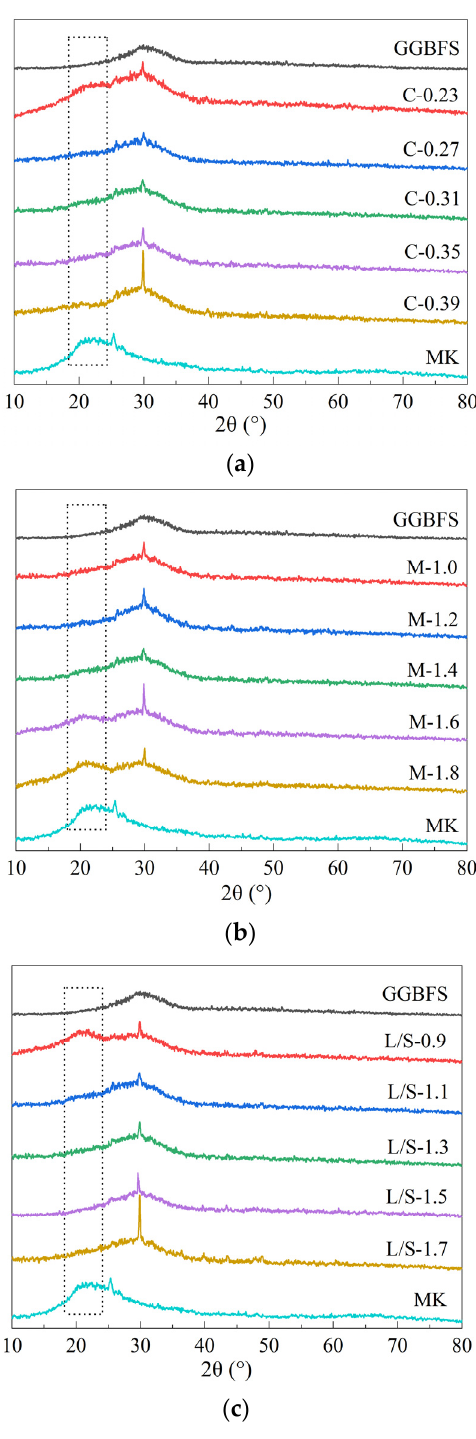
Figure 4. XRD patterns of samples under varying concentrations ( a ), moduli ( b ), and L/S ratio ( c ).